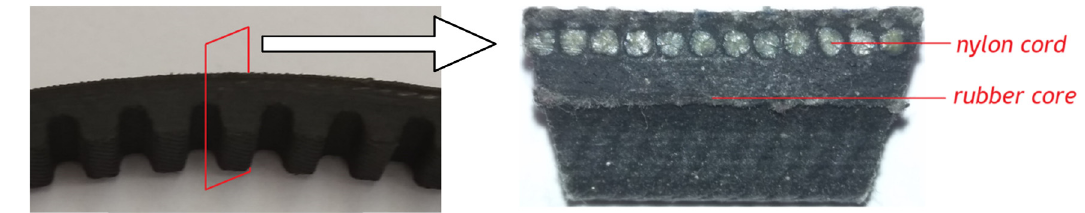
Figure 8: Cross section of CVT rubber belt ( Dayco 17.5 × 765 )